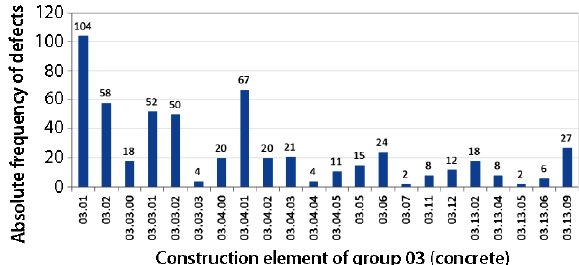
Fig. 10. Absolute frequency of defects according to the specific construction elements belonging to group 03 – concrete elements